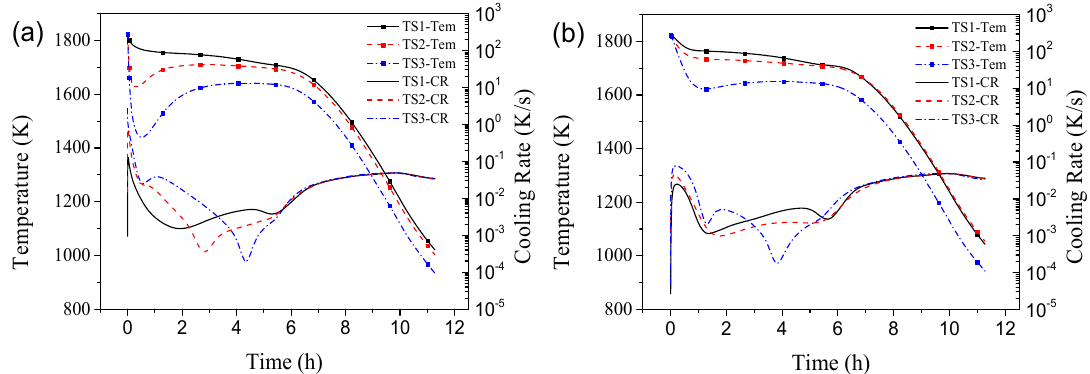
Figure 5. The evolution of temperature (tem) and cooling rate (CR) with time in three typical parts: ( a ) cold side (20 mm away from surface); ( b ) hot side (100 mm away from surface).